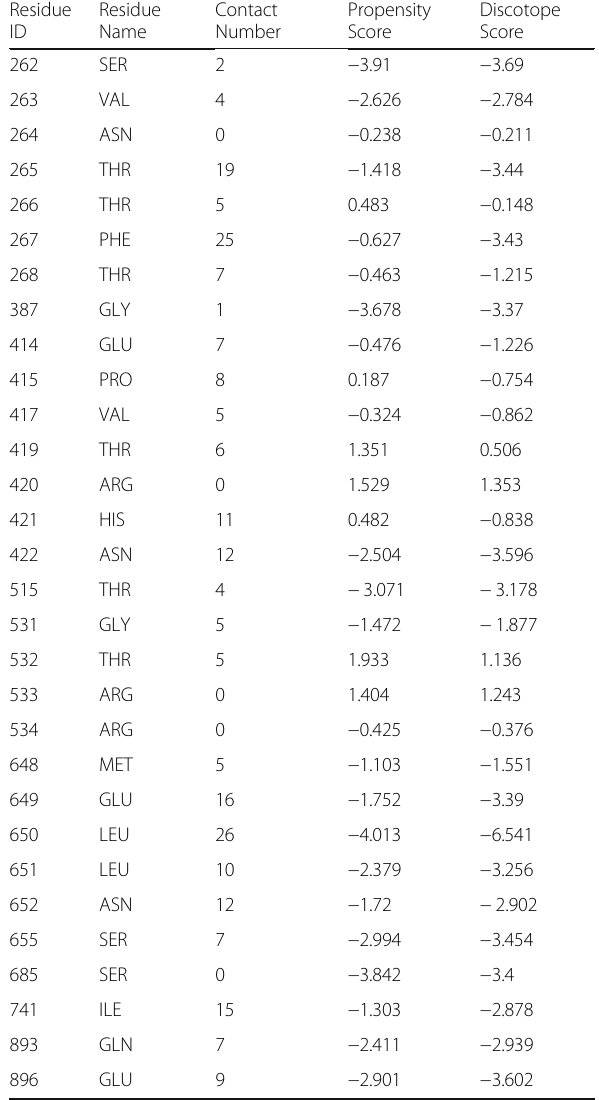
Table 5 Discontinuous epitopes predicted through DISCOTOPE 2.0 Server